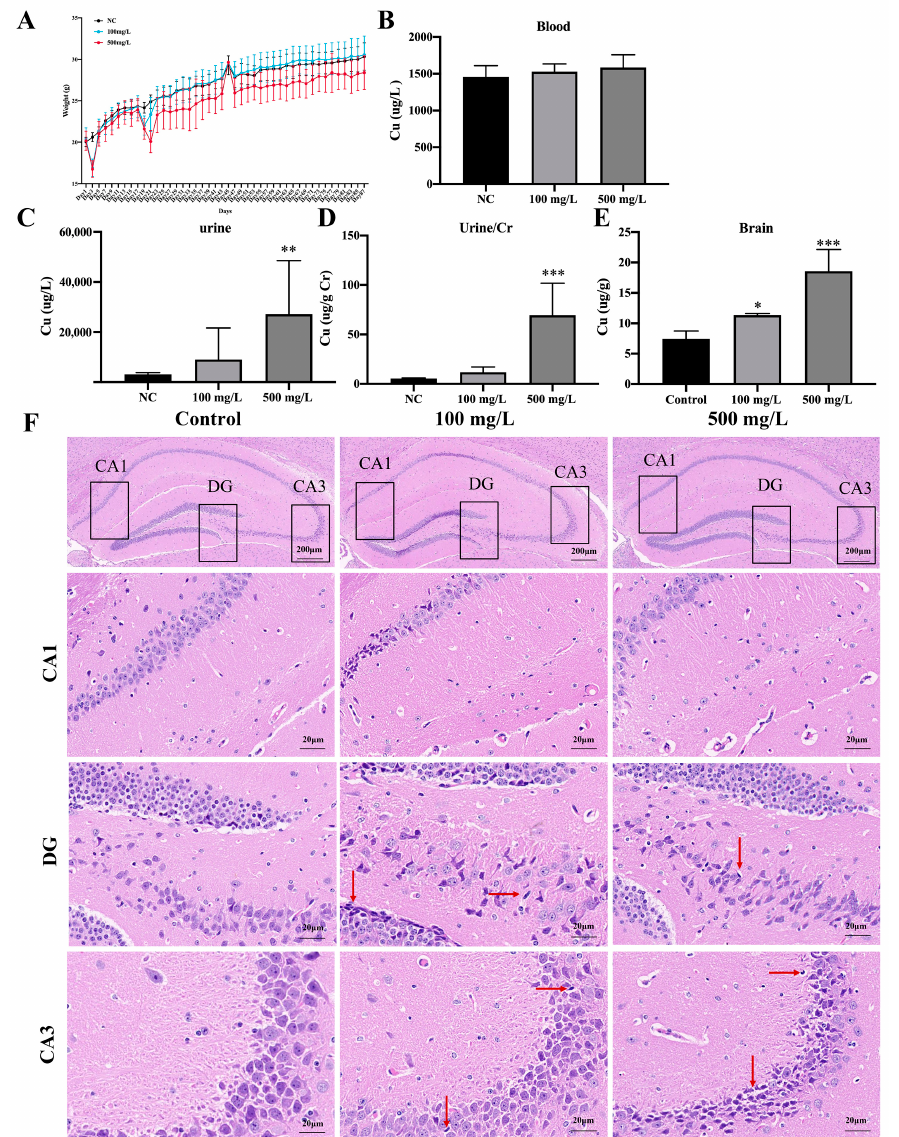
Figure 2. Cu exposure induces Cu accumulation and neuronal degeneration in mice hippocampus. ( A ) The body weight of the mice. ( B ) Cu level in blood of mice. ( C ) Cu level in urine of mice. ( D ) Creatinine-corrected Cu level in urine of mice. ( E ) Cu level in hippocampus tissue of mice. ( F ) HE staining of mice hippocampus after Cu exposure. Red arrows showed cells arranged in a disorderly manner, cytoplasm and nucleolus deeply dyed with nuclear pyknosis. Scale bar = 200 µm in first row, scale bar = 20 µm in figure of CA1, CA3 and DG regions. * p < 0.05, ** p < 0.01, *** p < 0.001.